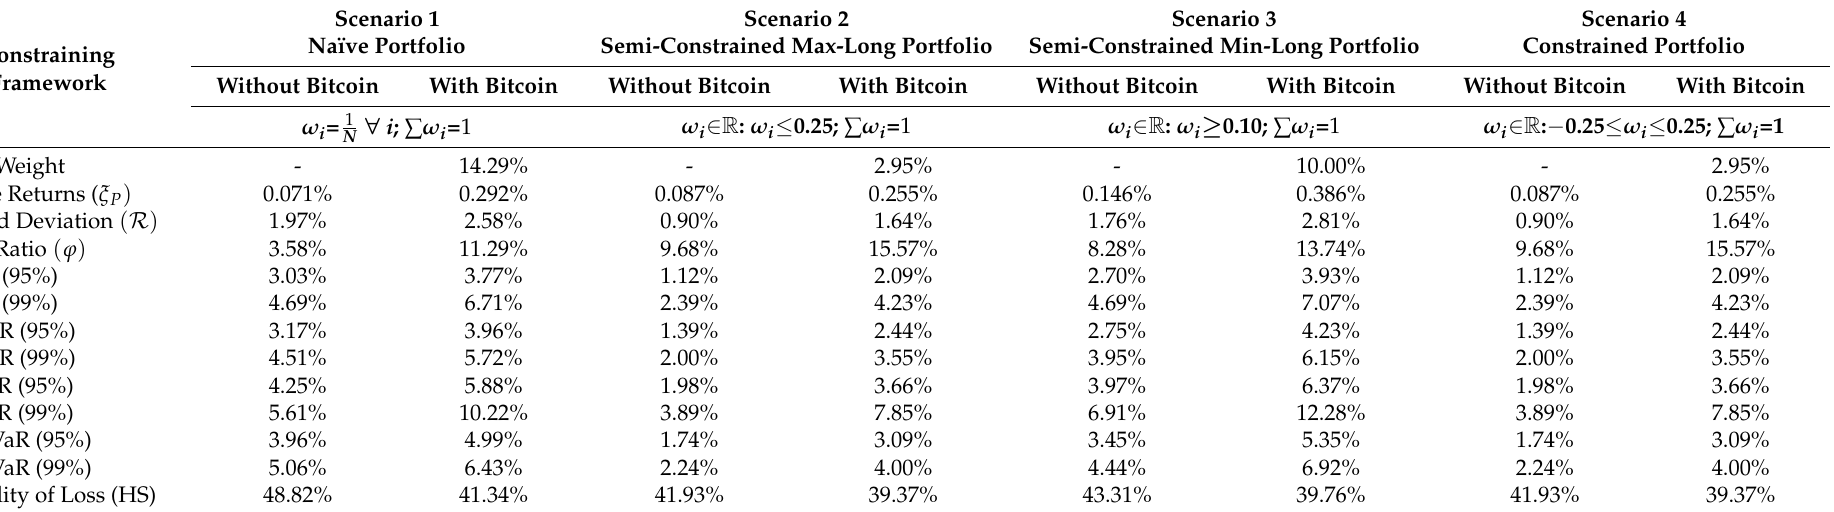
Table 4. Portfolio optimization (Scenario 1 to 4).